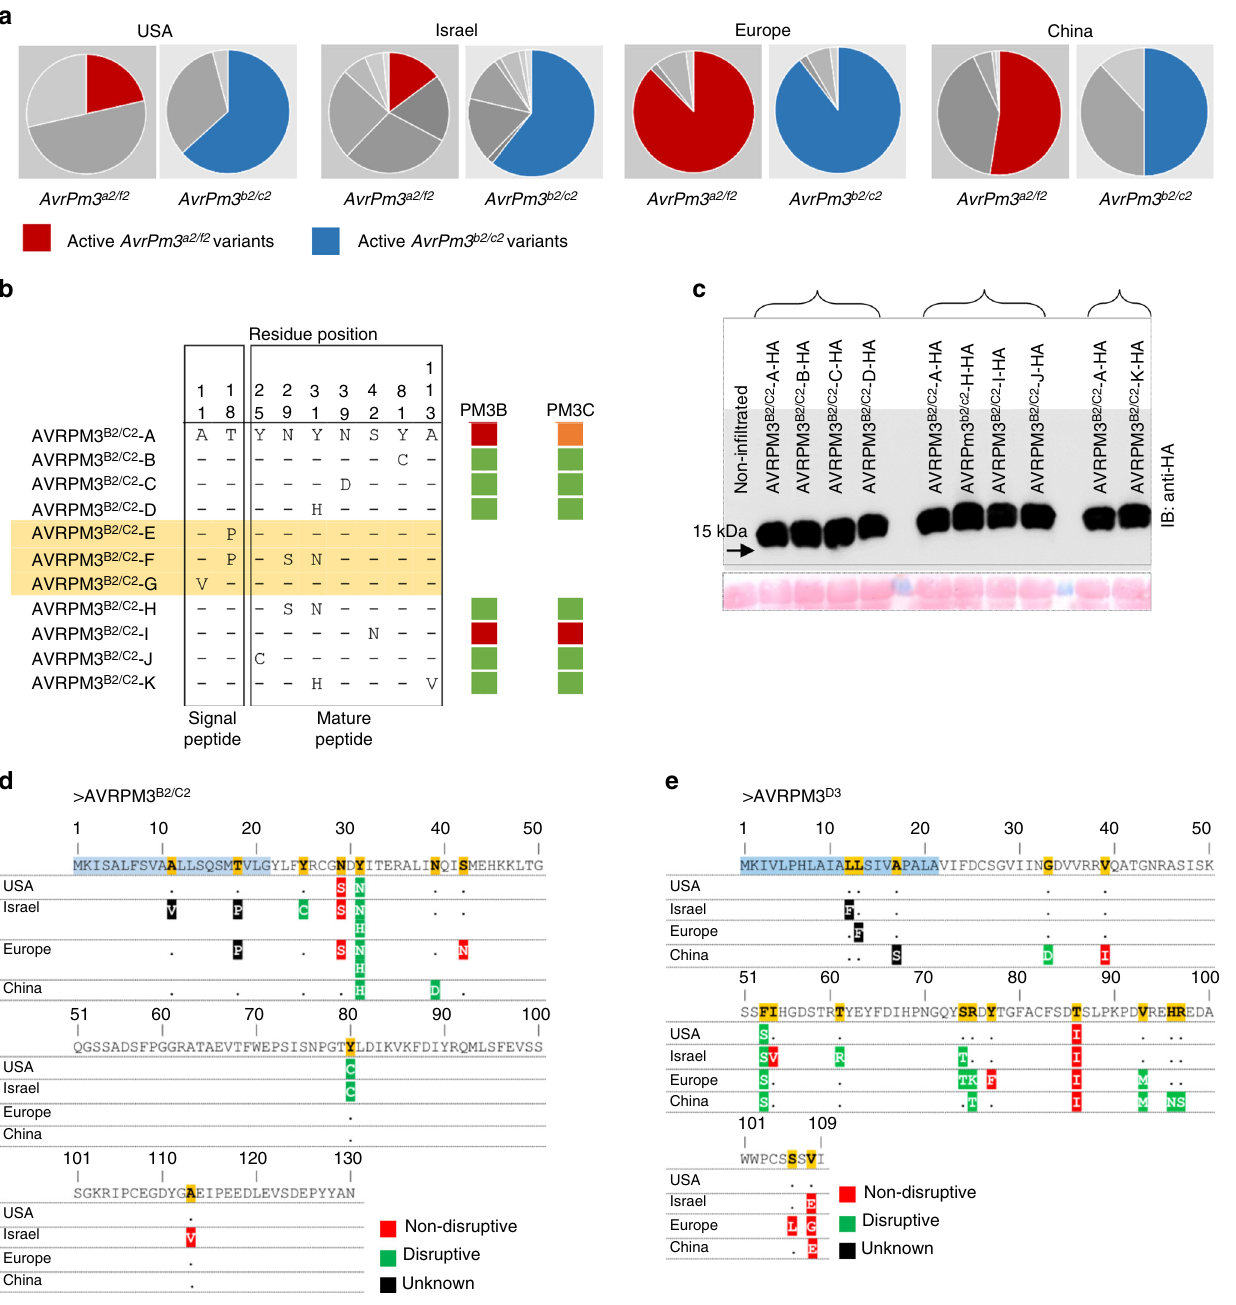
Fig. 4 Functional characterisation of AVRPM3 B2/C2 and AVRPM3 D3 based on natural and arti fi cial sequence variation. a Geographical distribution and frequency of AvrPm3 b2/c2 sequence haplotypes encoding active AVRPM3 B2/C2 virulence protein variant as compared to AvrPm3 a2/f2 . Underlying source data is provided in a Source Data File. b Summary of AVRPM3 B2/C2 haplovariants, only polymorphic residues are depicted. Strong recognition by PM3B and PM3C based on N. benthamiana in fi ltration assays are indicated with a red box, and weak recognition with an orange box. All assays are based on expression of the mature protein after removal of the signal peptide. Therefore, haplovariants E and G, and haplovariant F were not tested because the mature protein sequence is identical to variant A and variant H, respectively. c Western blot detection (upper panel) of C terminal HA epitope fusion to the mature proteins of the AVRPM3 B2/C2 haplovariants. Ponceau staining of the western blot membranes is depicted in the lower panel. Braces indicate samples where all constructs were combined on the same leaf and rotated together with AVRPM3 B2/C2 -A as a reference. Uncropped Western blot images are provided in a Source Data File. d , e Functional characterisation of the impact of natural sequence diversity of AVRPM3 B2/C2 ( d ) and AVRPM3 D3 ( e ) on AVR detectable on a western blot (Supplementary Fig. 19). Interest- NLRs (Fig. 4d, e), suggesting that selective pressure to escape R gene recognition is a driving force for sequence diversi fi cation of AVRPM3 B2/C2 and AVRPM3 D3 . Protein expression analysis demonstrated that loss of AVRPM3 B2/C2 recognition is not due to absence of the protein as all point mutants are equally residues (aa 25 – 42), immediately after the predicted signal